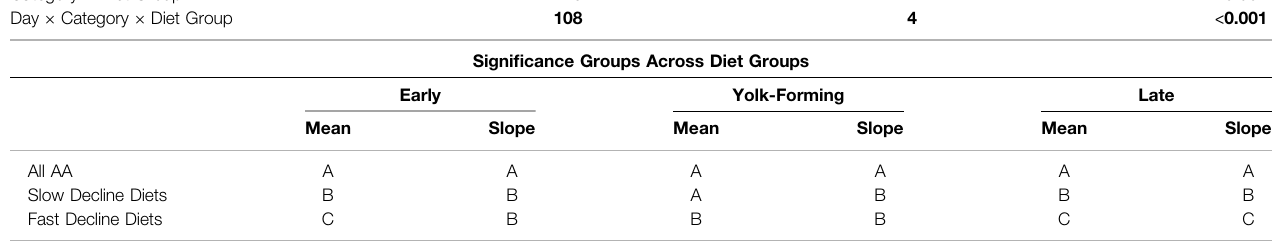
P-values in bold indicate signi fi cant terms.